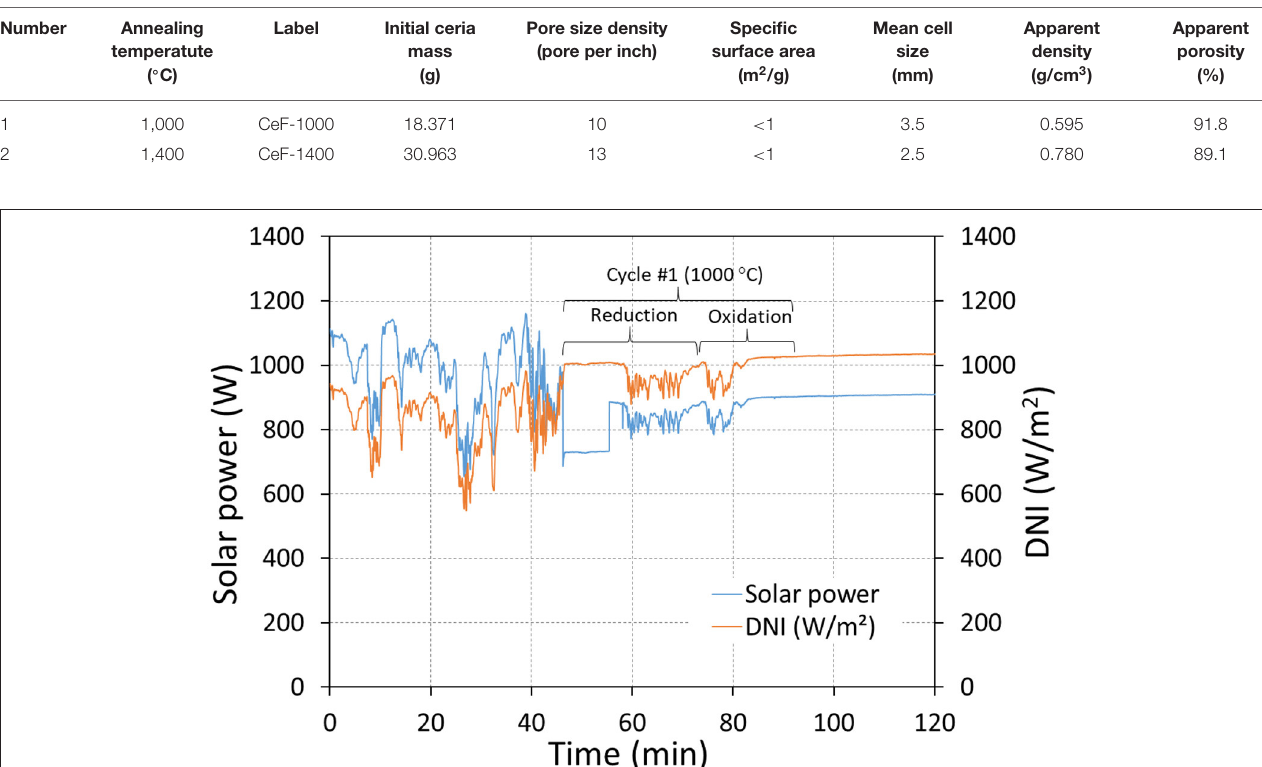
TABLE 1 | Physical properties of ceria foams.